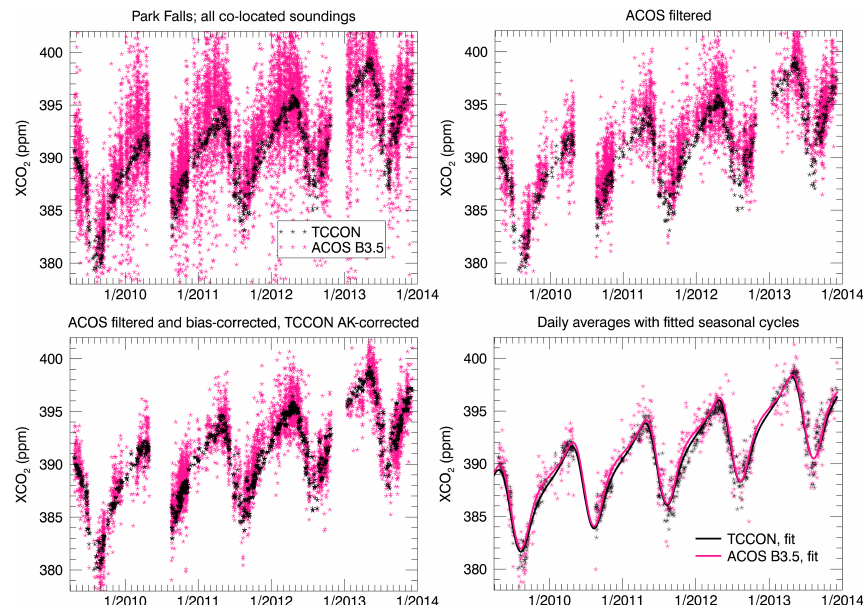
Figure 3. An example of data processing and the seasonal cycle fitting procedure at Park Falls. The upper left panel shows time series of the retrieved XCO 2 for all co-located TCCON (black) and GOSAT/ACOS (pink) soundings. The upper right figure shows only those ACOS L2 soundings that pass the post-processing filters. The lower left figure has bias correction applied for ACOS data and averaging kernel correction considered for TCCON soundings. The lower right panel shows the daily averages of XCO 2 and the respective seasonal cycle